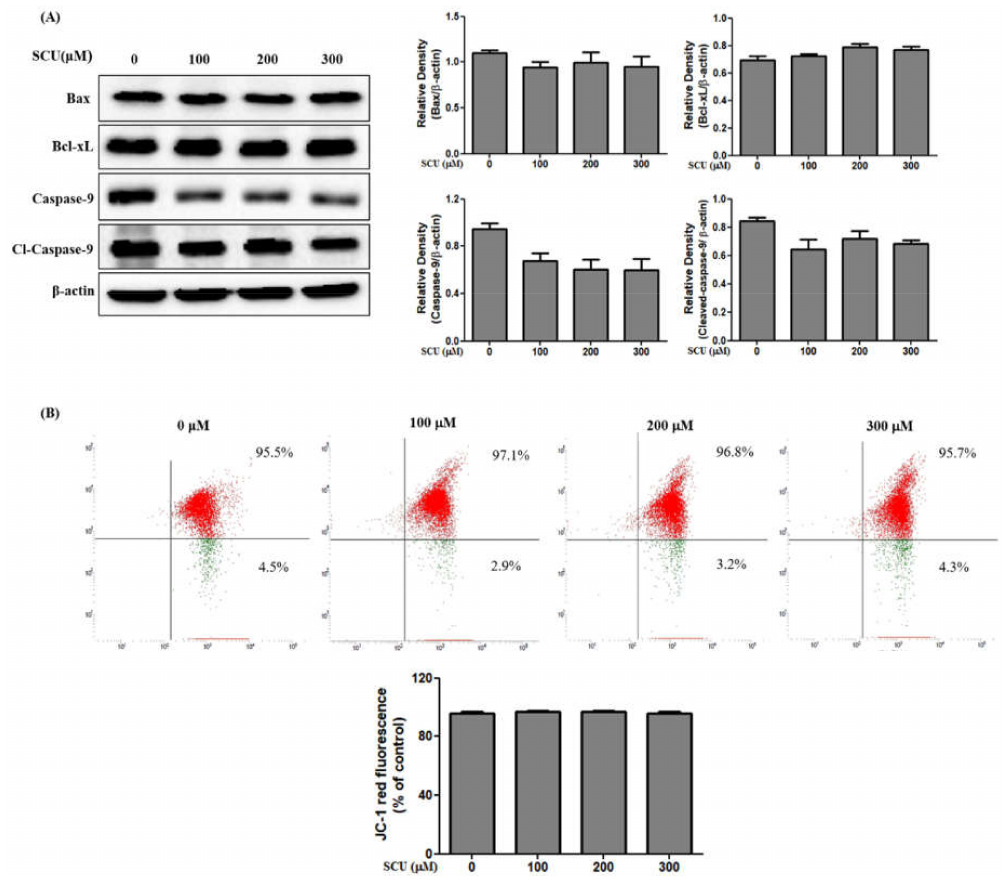
Figure 5. Scutellarein (SCU) does not induce the intrinsic apoptosis pathway in Hep3B cells. ( A ) The cells were treated with SCU at indicated concentrations (0-, 100-, 200-, and 300- µ M) for 24 h. Total cell lysates were resolved in sodium dodecyl sulfate (SDS)-polyacrylamide gels and transferred onto polyvinylidene difluoride (PVDF) membranes. The membranes were ( B ) The cells